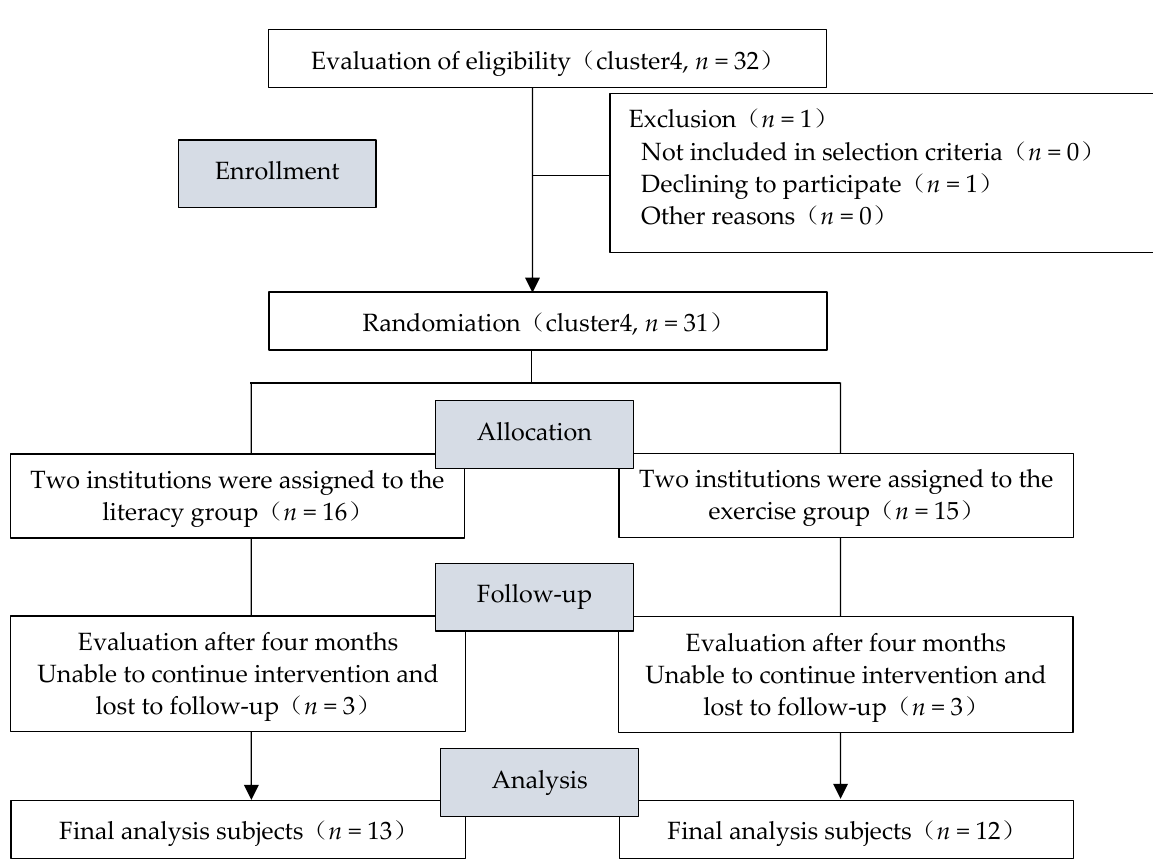
Figure 2. Flowchart showing cluster random assignment and the process of each stage.